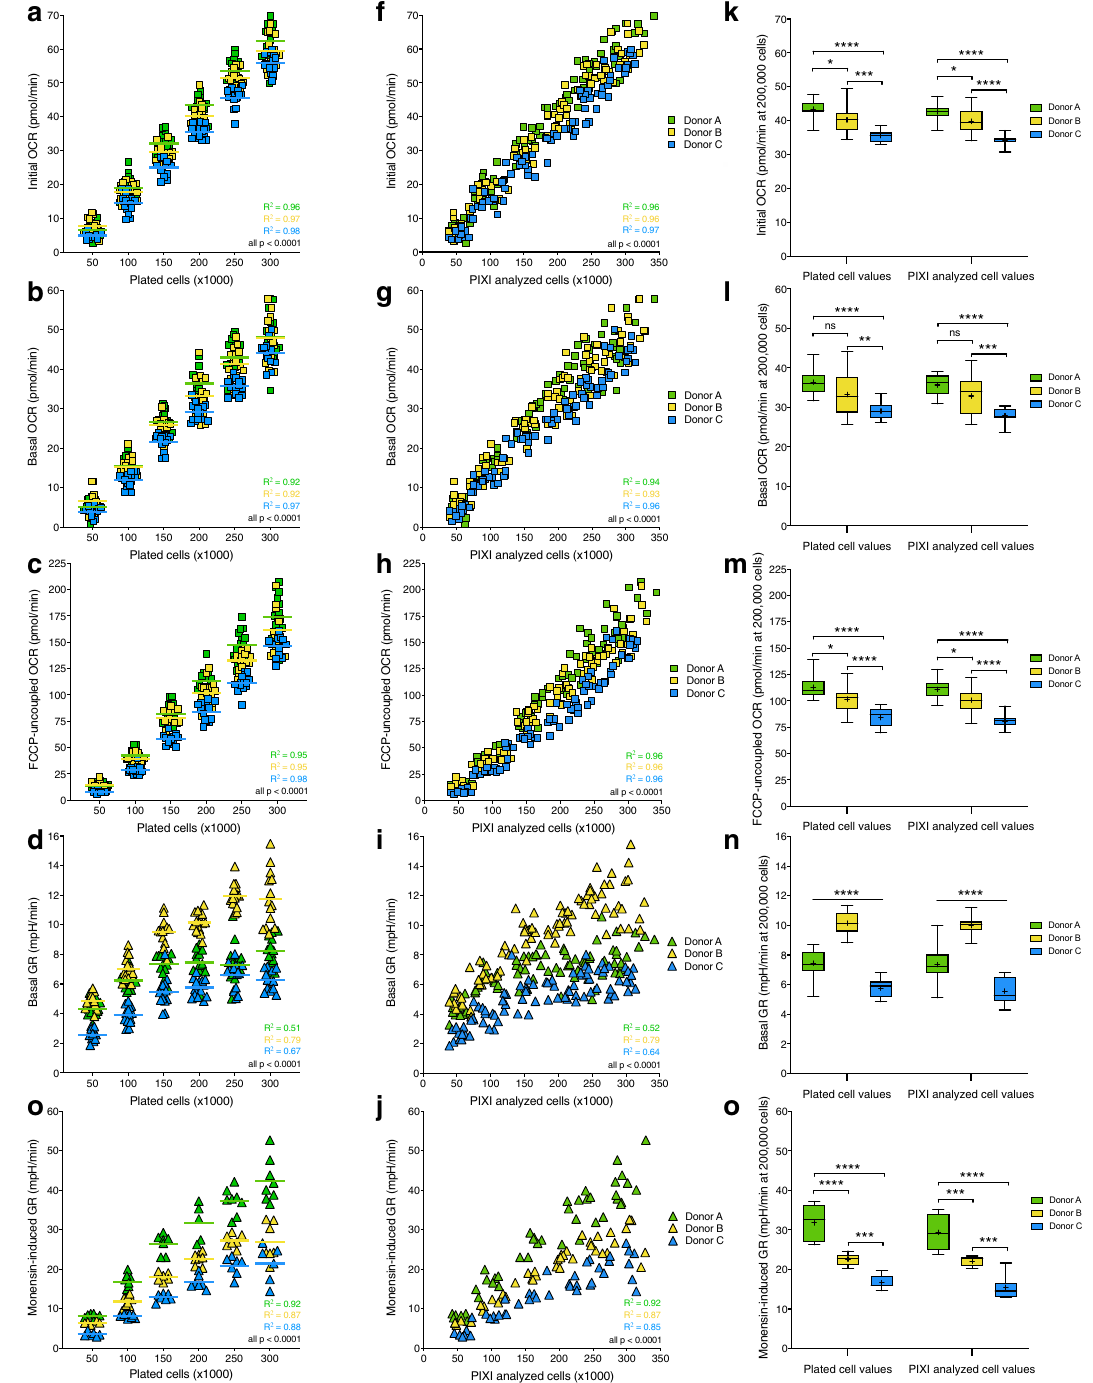
Figure 4. PIXI analysis preserves the correlations between the number of plated cells and XF assay parameters. ( a – j ) Comparison of the linear relationship between initial OCR, basal OCR, FCCP-uncoupled OCR, basal GR or monensin-induced GR and number of plated cells ( a – e ) or number of PIXI analyzed cells ( f – j ) (50–300 × 10 3 cells/well, n = 14–16). Means at each seeding density ( a – d ) are represented by a dash ( ⎯ ). ( k – o ) Comparison of mean OCR and GR levels between donor A, B and C at 200,000 plated cells (left) or at 200,000 PIXI analyzed cells (right) per well (n = 16). Data is represented as mean ± range. Means are represented by a plus sign (+). ns not significant; *p < 0.05; **p < 0.01; ***p < 0.001; ****p <